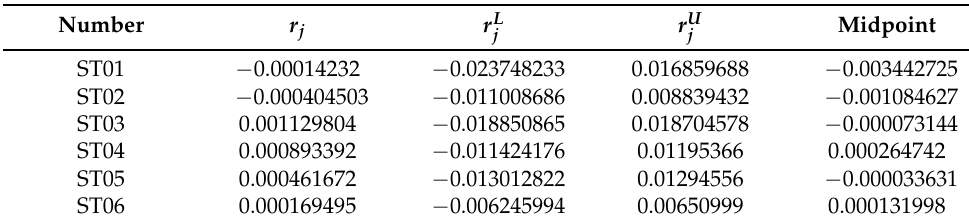
Table 9. Return, data from international market.